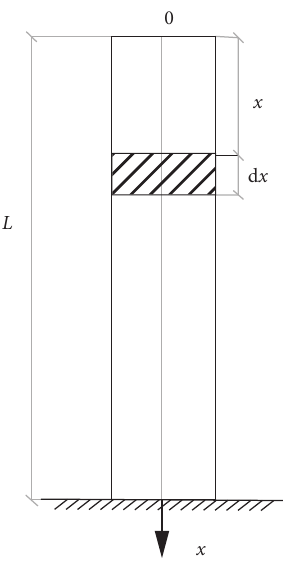
Figure 1: One-dimensional elastic